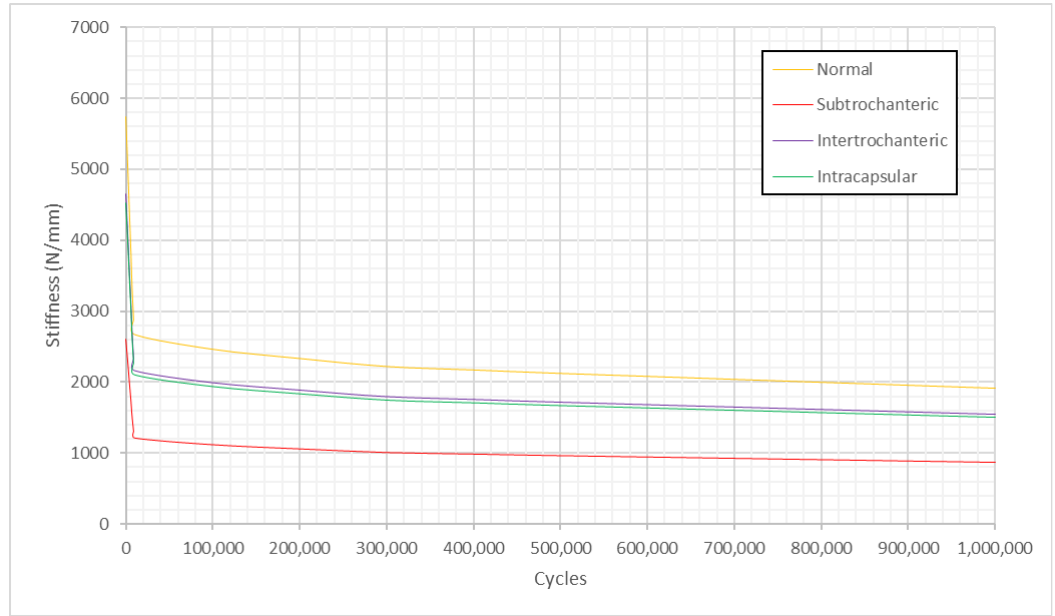
Figure 14. Stiffness versus fatigue cycles under the torsion scenario during cyclic loading.